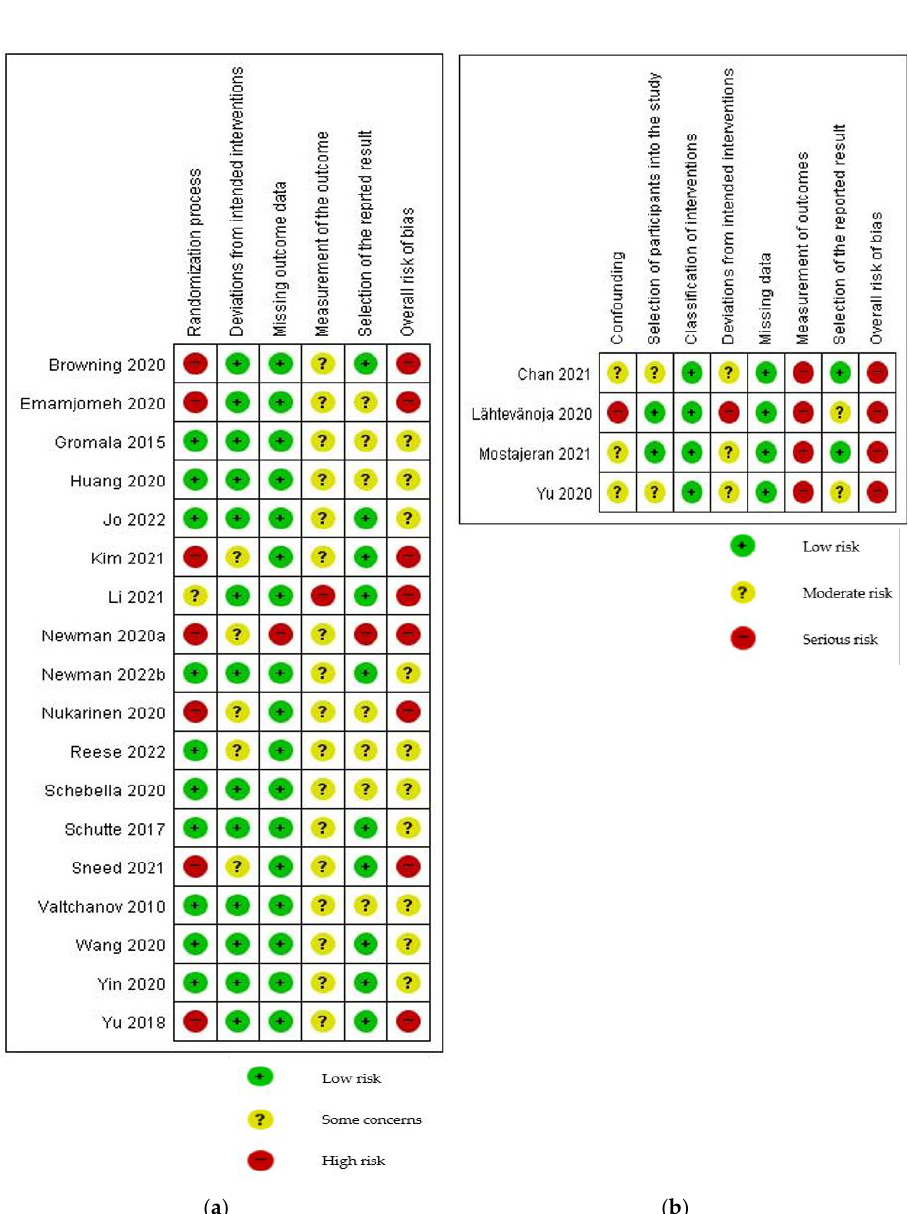
Figure 2. Risk of bias in included studies: ( a ) Risk of bias in randomized controlled trials using the RoB 2 tool; ( b ) Risk of bias in non-randomized controlled trials using the ROBINS-I